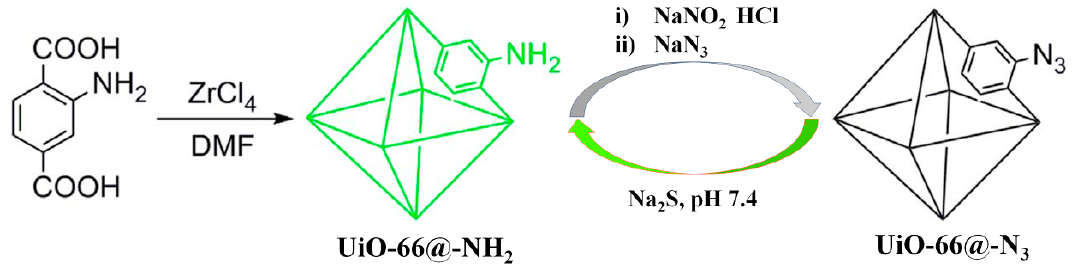
Figure 2. The synthetic route and sensing mechanism of UiO-66@N 3 for H 2 S. Reproduced with permission from [71]. Copyright Nature Publishing Group, 2014.